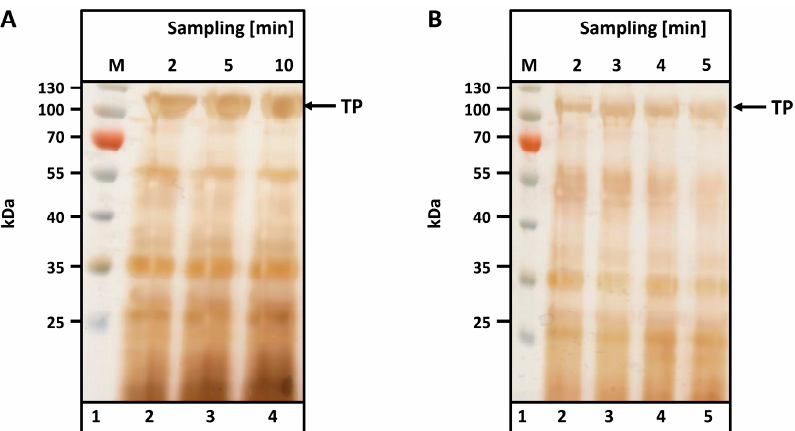
Figure 3. Release of K-MaSp1-100× ELP during cell disruption using: ( A ) a Waring blender; and ( B ) a table top cutter. Nicotiana tabacum leaves were incubated in a microwave and then stored at − 20 °C. ( A ) Three hundred grams BWM2 were thawed (16 h, 4 °C), mixed with 450 mL tap water (4 °C) and sheared in a Waring blender for 10 min; ( B ) Five kilograms leaves in 6 L tap water (4 °C) were disintegrated using a table top cutter for 5 min. Samples were taken at the indicated time points. After centrifugation, 500 µL of the supernatant was dried and resolubilized in 200 µL SDS sample buffer. M-Prestained protein ladder. The arrow indicates the molecular size of the target protein (TP).